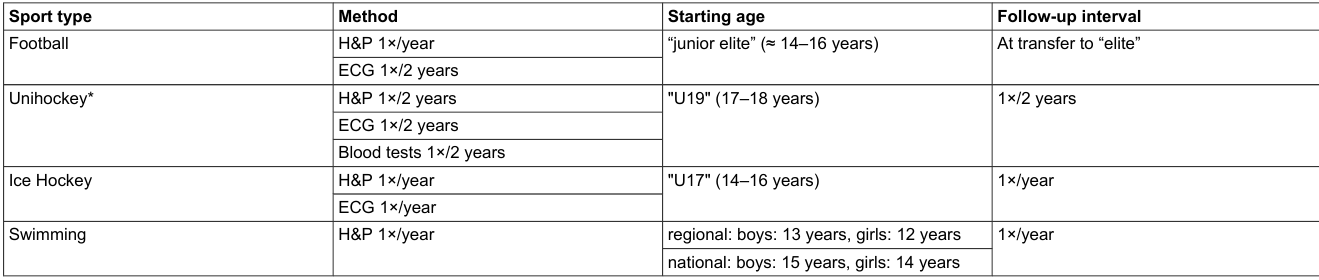
Table 3: Current PPCE standards for major sport types in paediatric and adolescent athletes in Switzerland.